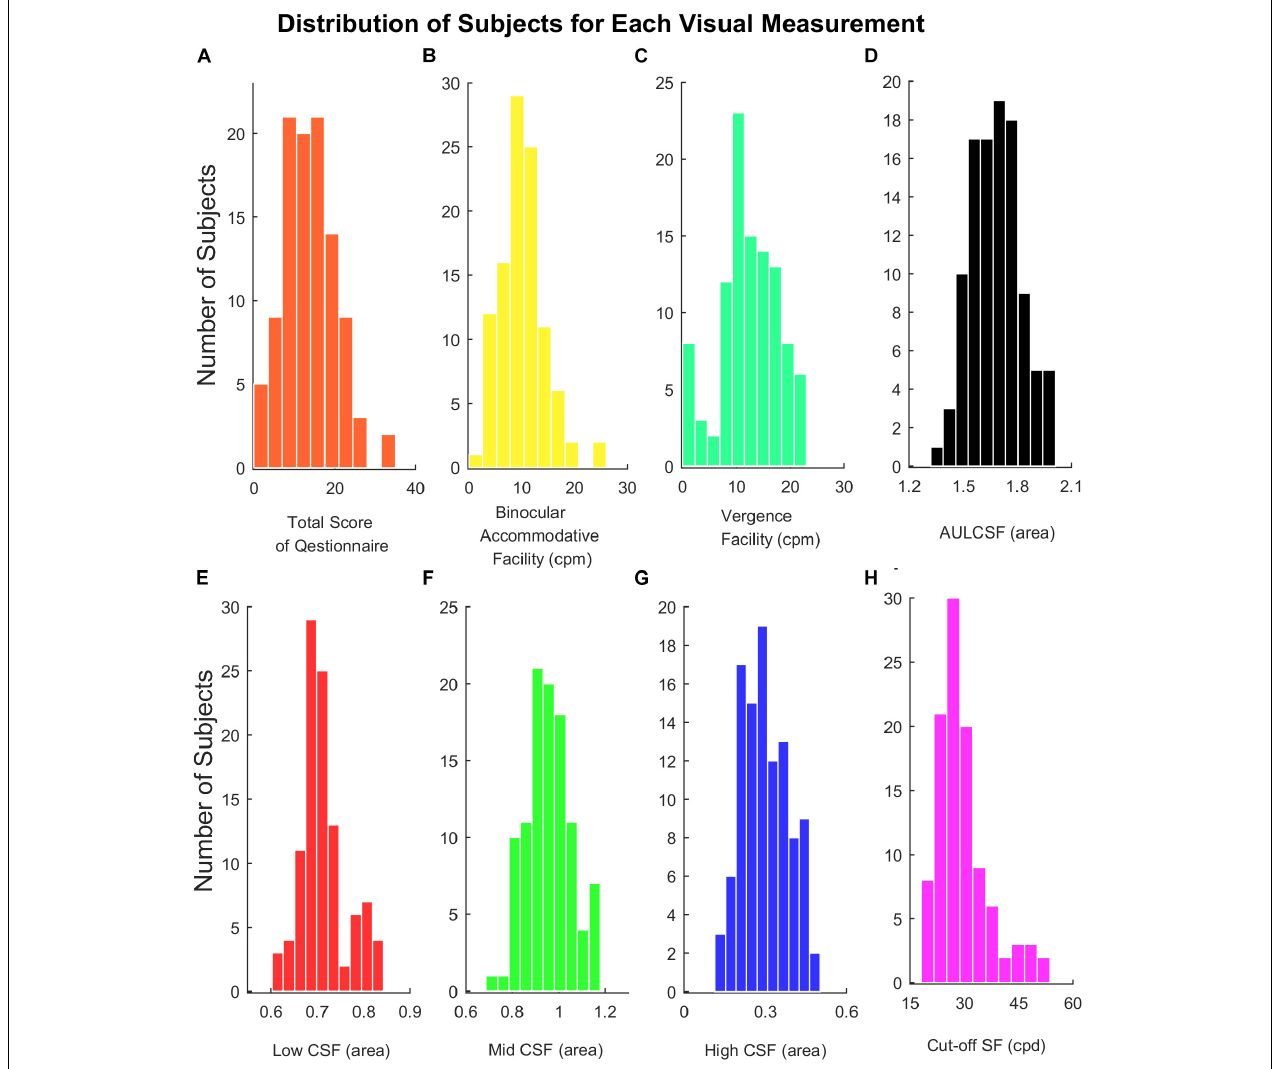
FIGURE 3 | (A) Histograms of total score of the questionnaire. (B) Binocular accommodative facility. (C) Vergence facility. (D) AULCSF. (E) Low CSF. (F) Mid CSF. (G) High CSF. (H) Cut-off